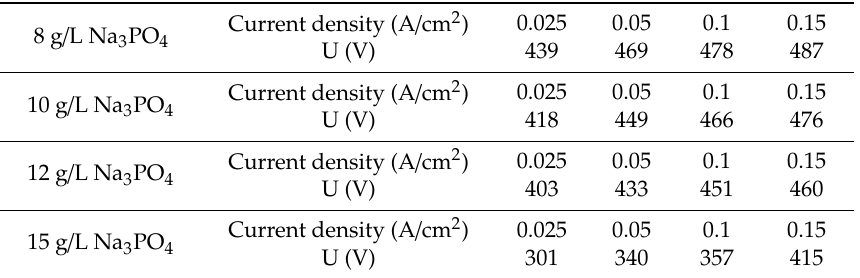
Figure 2. Equivalent circuits used for the analysis of Nyquist diagrams with one capacitive loop ( a ) and two capacitive loops ( b , c ).